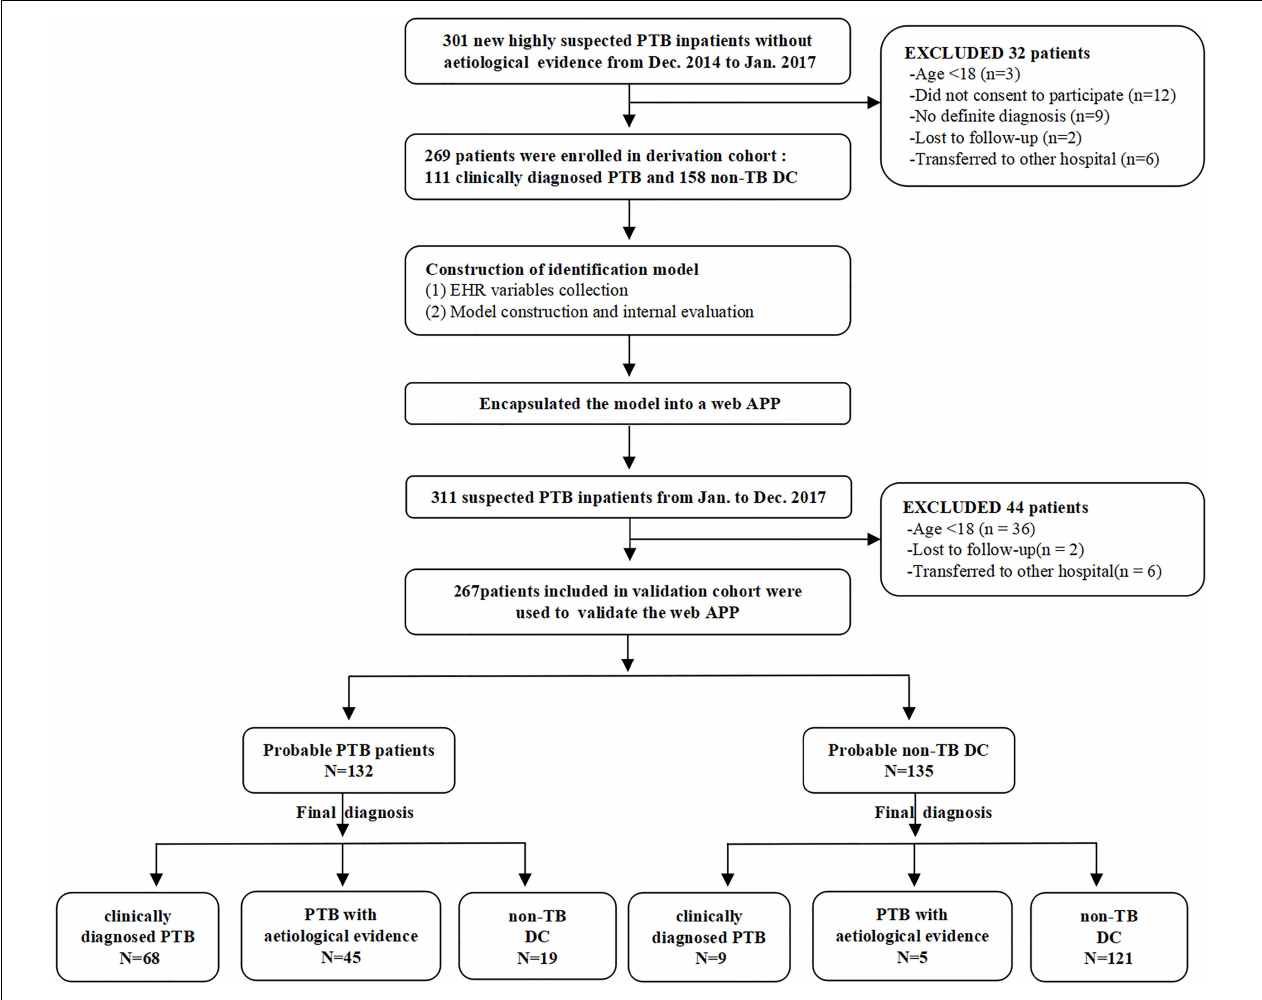
FIGURE 1 | Study flow